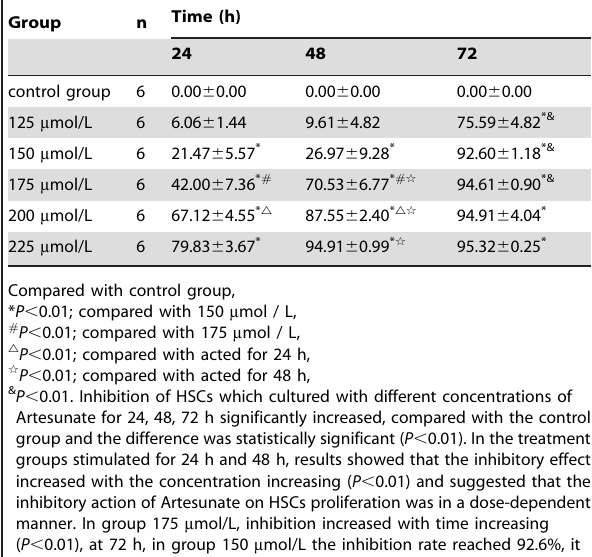
Figure 2. Hepatic stellate cells growth curve. The second generation of HSCs were collected and seeded in 96-well plates by density of 5 6 10 4 /well, the absorbance was measured with microplate reader ( l 570 nm), culture time as abscissa, absorbance value as ordinate. HSCs were proliferated after 72 h, turning into the logarithmic growth phase on the 4th, 5th day and into the plateau phase on the